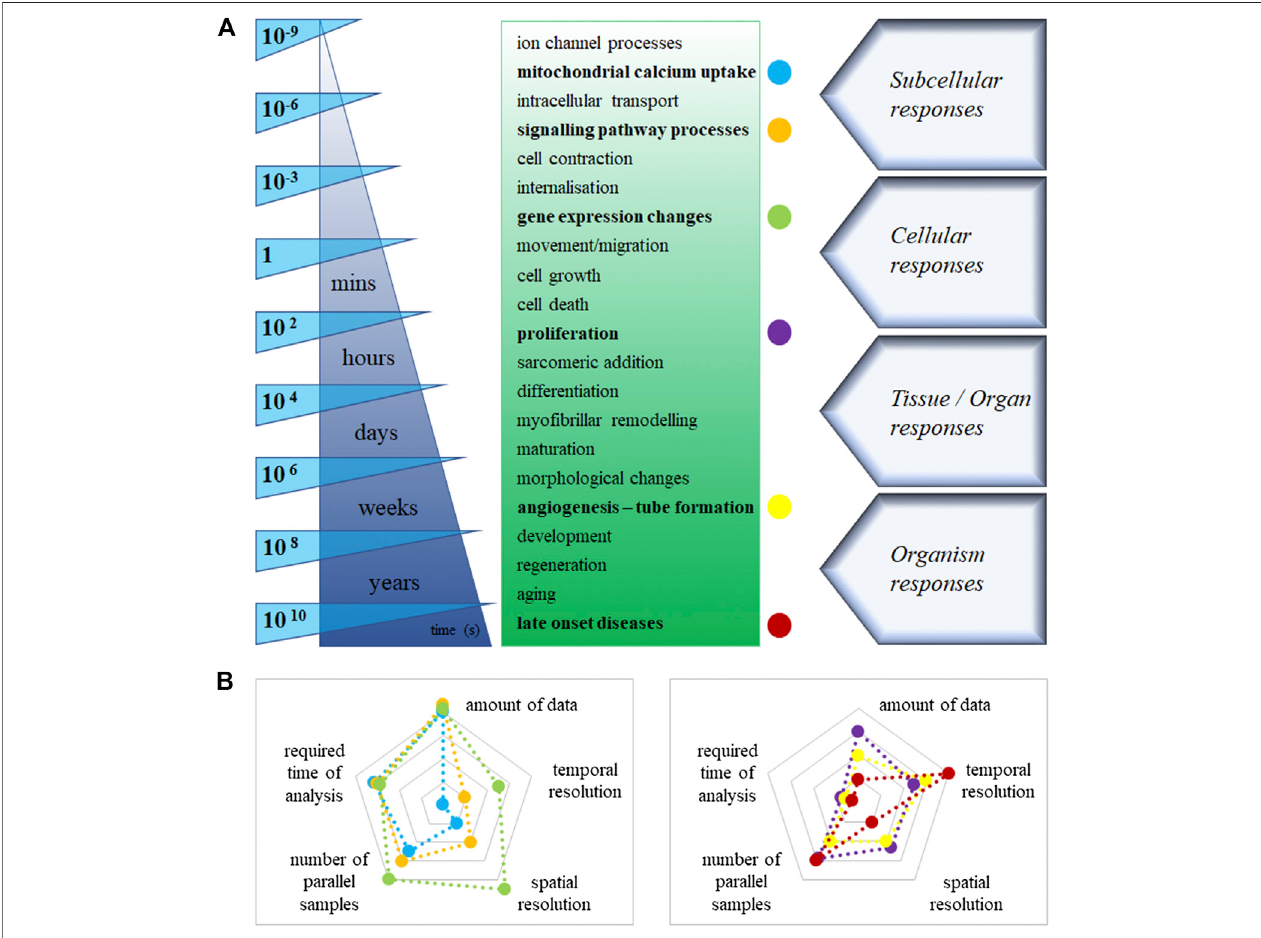
FIGURE 2 | (A) : Estimated timeline of the main cellular processes in cardiovascular cells. (B) : Labeled cellular processes [colored dots in Panel. (A) ], displayed on two-dimensional spider charts. The logarithmic scales demonstrate the values of different technical necessities, increasingly from the centre to the edges in the graph.